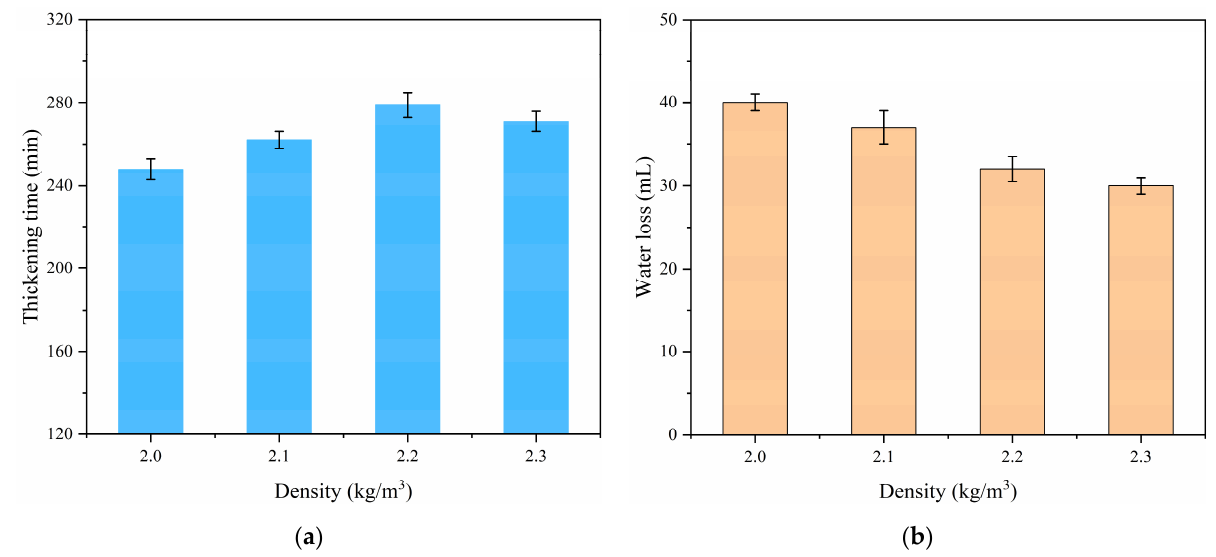
Figure 8. Thickening time and water loss of cement slurries with different densities.( a ) Thickening time; ( b ) Water loss.